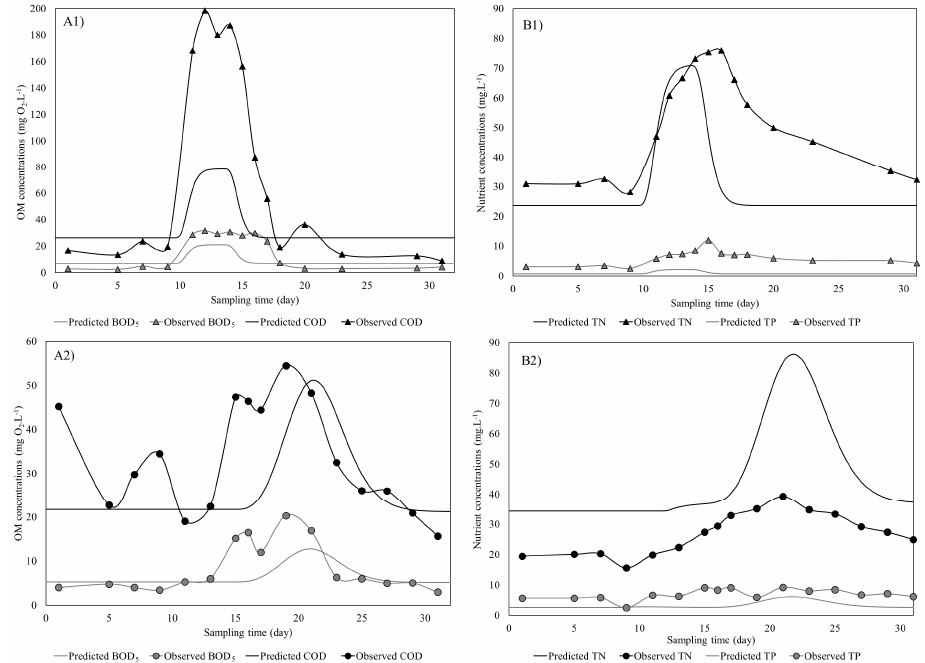
Figure 5. Predicted and observed effluent concentrations of constructed wetlands (CW) and waste stabilization ponds (WSP) systems during the peak scenario (( A ): Organic Matter (OM), ( B ): nutrients, 1: CW, 2: WSP).